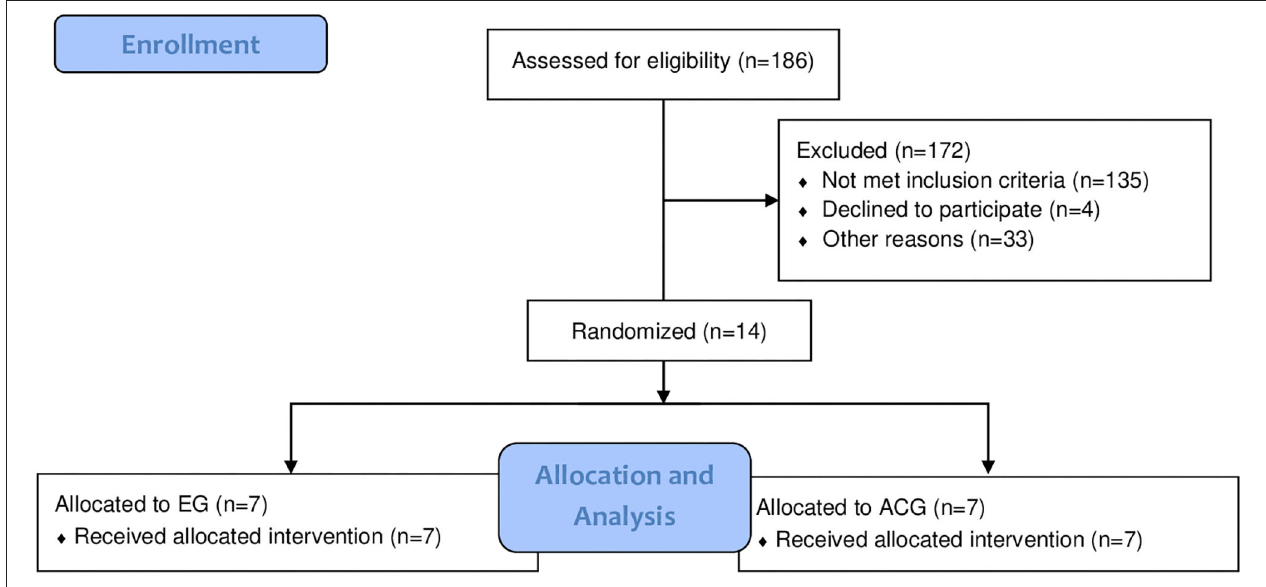
FIGURE 1 | Flowchart indicating the recruitment